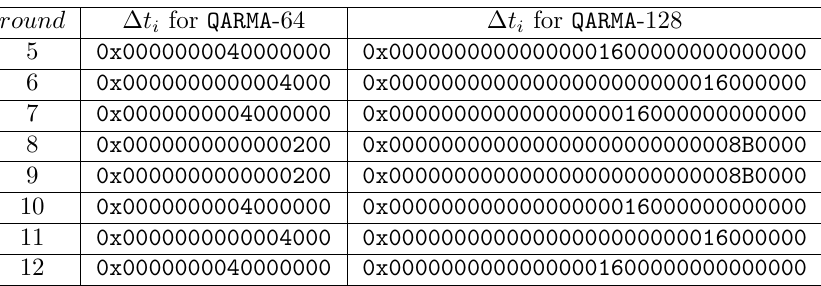
Table 6: Difference of Round Tweak for No. 1 Distinguisher